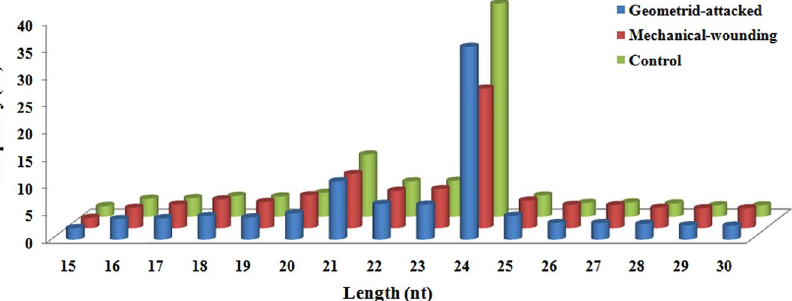
Figure 1. Size distribution and abundances of small RNAs in the libraries of the geometrid-attacked, mechanical-wounding and control samples of Camellia sinensis